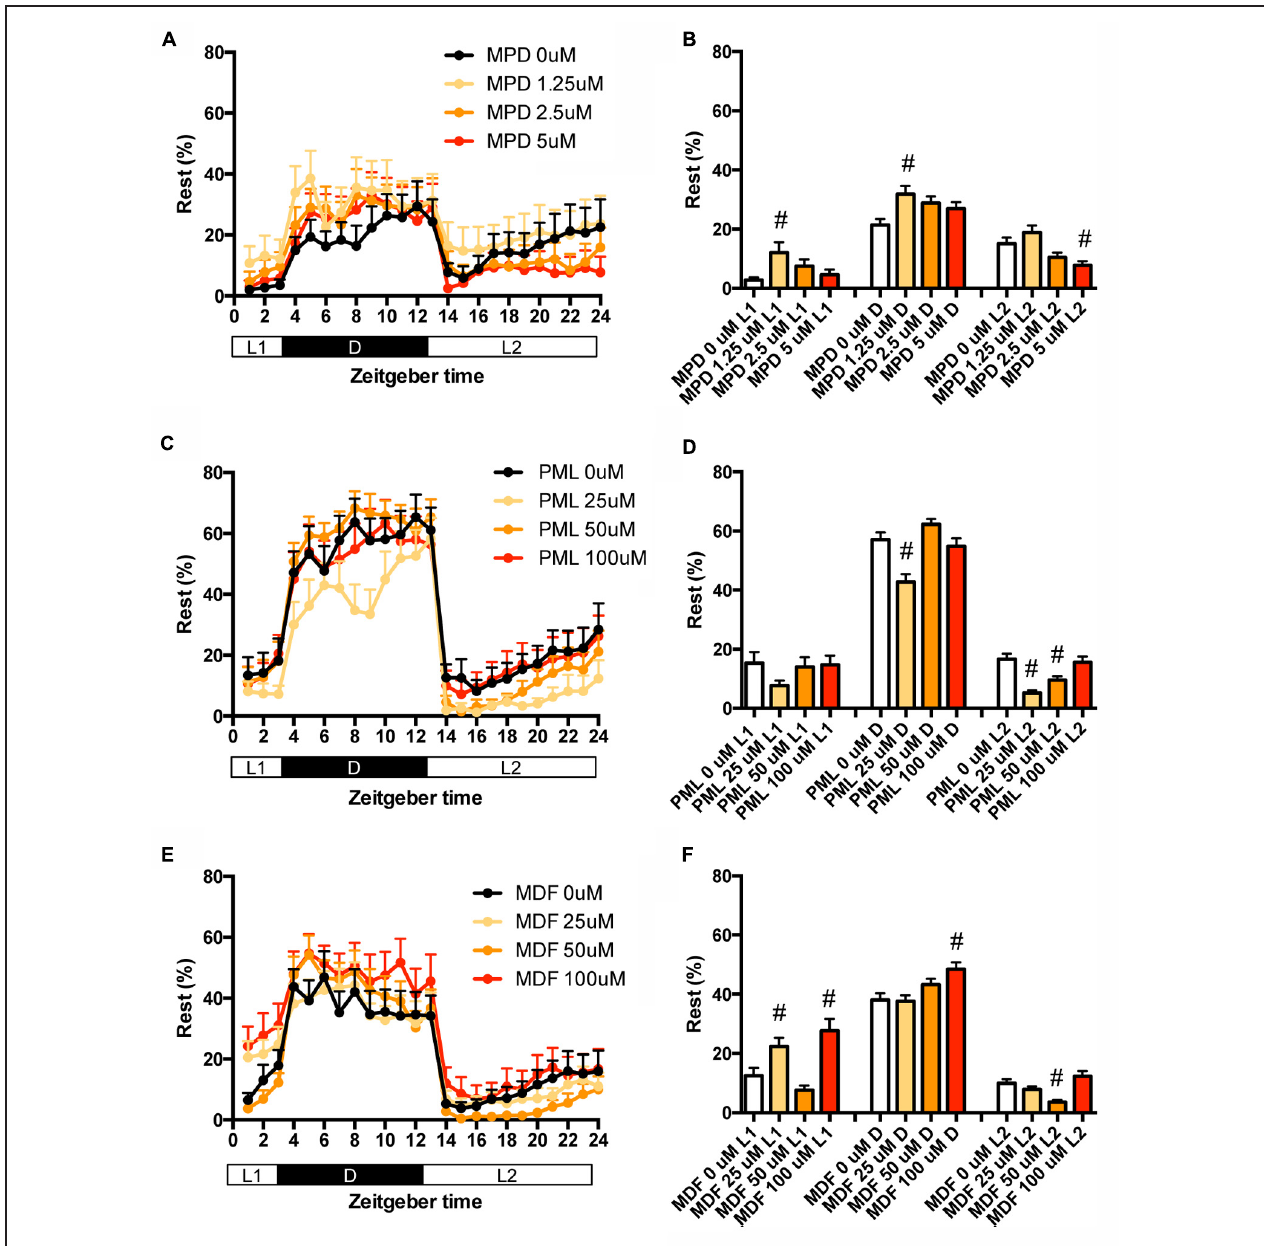
FIGURE 6 | Effects of methylphenidate, pemoline, and modafinil on the rest state of zebrafish. The rest state of zebrafish treated with methylphenidate (A) , pemoline (C) , and modafinil (E) from 9 to 10 dpf is indicated as percentage of total behavior during the hour. The rest state of zebrafish treated with methylphenidate (B) , pemoline (D) , and modafinil (F) from 9 to 10 dpf is indicated as percentage in L1, D, and L2. The data are represented as means with the standard error of mean. # p < 0.05 vs.